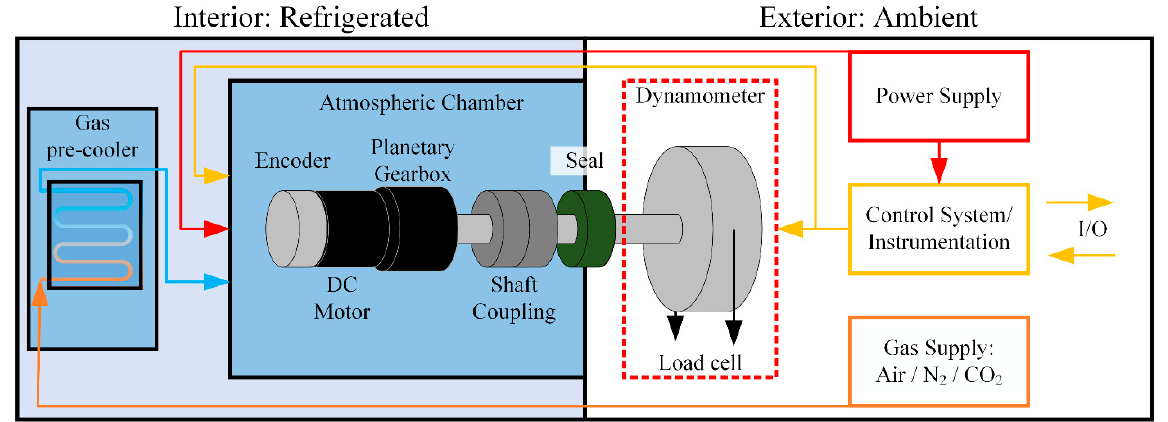
Figure 1. Schematic displaying general outline and salient sub systems of the geared actuator test rig (GATR).